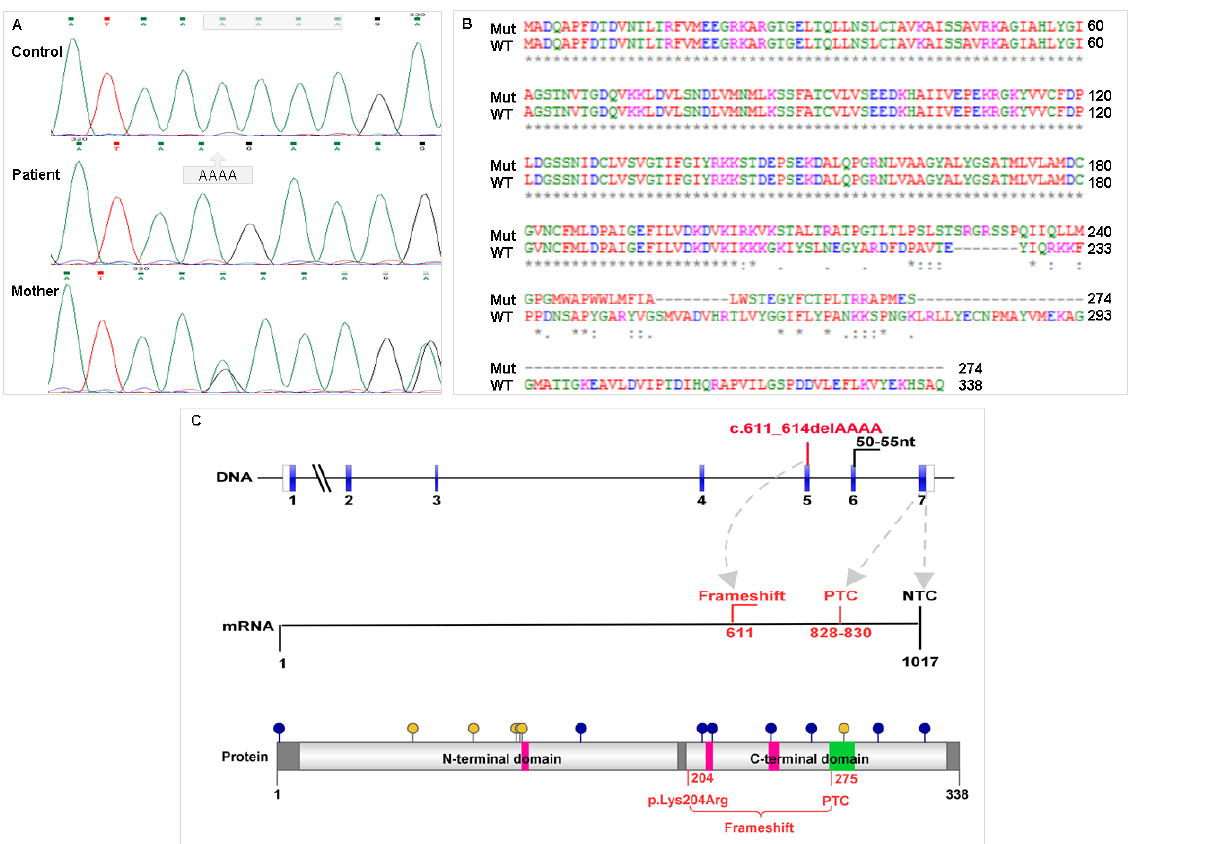
Figure 1 – Sequences analysis of the FBP1 gene and fructose-1,6-bisphosphatase. A) Electropherogram of control, patient and her mother evidencing the affected region in the FBP1 gene. The control sample is a normal homozygous to the analyzed region; in their electropherogram, the gray rectangle indicates the deleted nucleotides in the patient. Highlighted in the second electropherogram, the position of the nucleotides deleted in a homozygous patient to the variant NM_000507.3:c.611_614del in FBP1 gene. The mother's electropherogram evidences that she is a carrier of the variant in analysis. B) Amino acid sequence of the FBPase resulting from the pathogenic variant (mut) in comparison with the wild type (WT). C) Diagram representing FBP1 DNA, FBP1 mRNA, and FBPase variant. In DNA, the blue boxes indicate the coding exons and the region of 50-55 nucleotides upstream of the last intron that is susceptible to scaping NMD is indicated. Red indicates the variant position in DNA and its consequences in mRNA and FBPase protein. Gray arrows refer to the start of the frameshift, PTC (premature terminator codon) and NTC (normal terminator codon) between DNA and mRNA. In the protein diagram, blue dots indicate modified amino acids; yellow dots indicate metal binding sites; in pink the substrate binding regions and in green the active site. RefSeq: NM_000507.3 and P09467. The FBPase domains were named according Pfam.